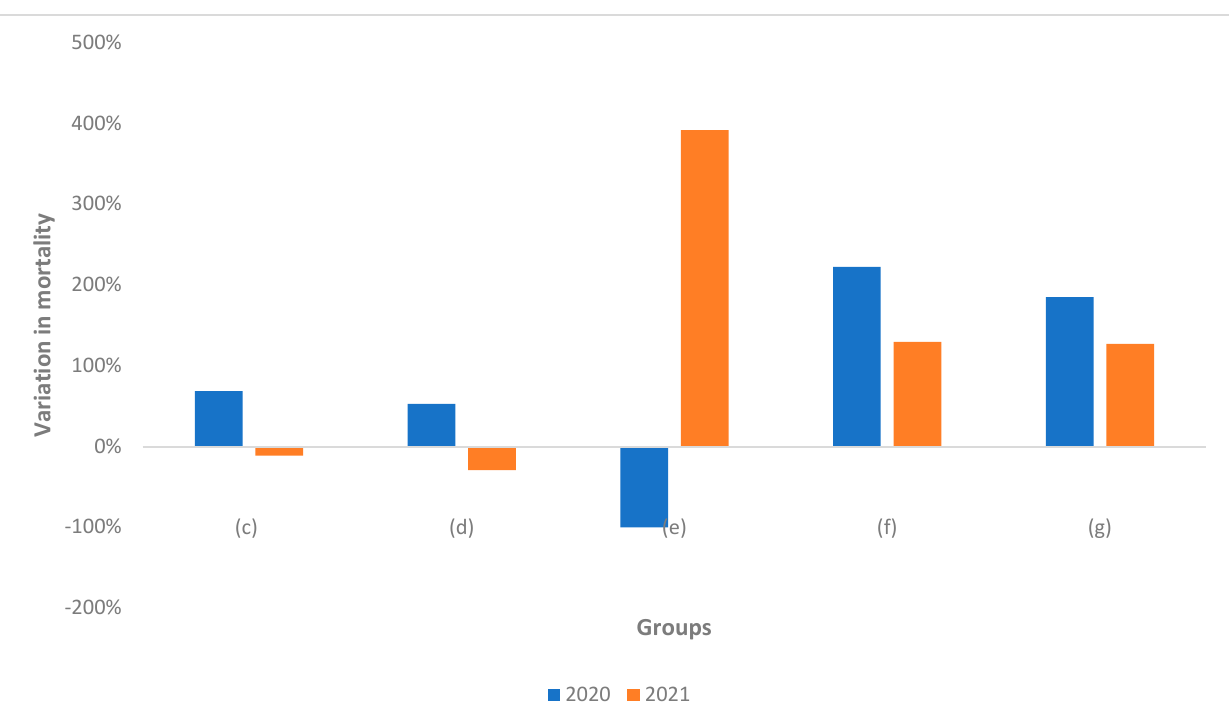
Figure 5. Mortality rate among physicians and dentists in the province of Pavia. (c): All Doctors, (d): Physicians, (e): Dentists, (f): Physicians-Dentists, (g): All Dentists.